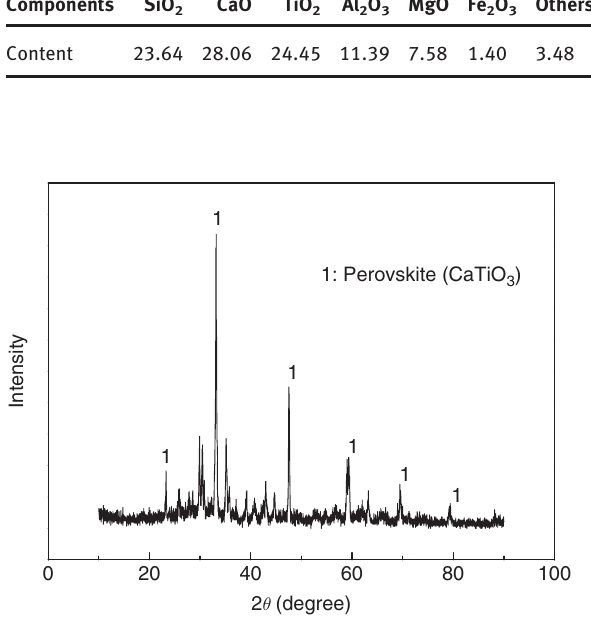
Figure 1: XRD patterns for titanium-bearing blast furnace slag in